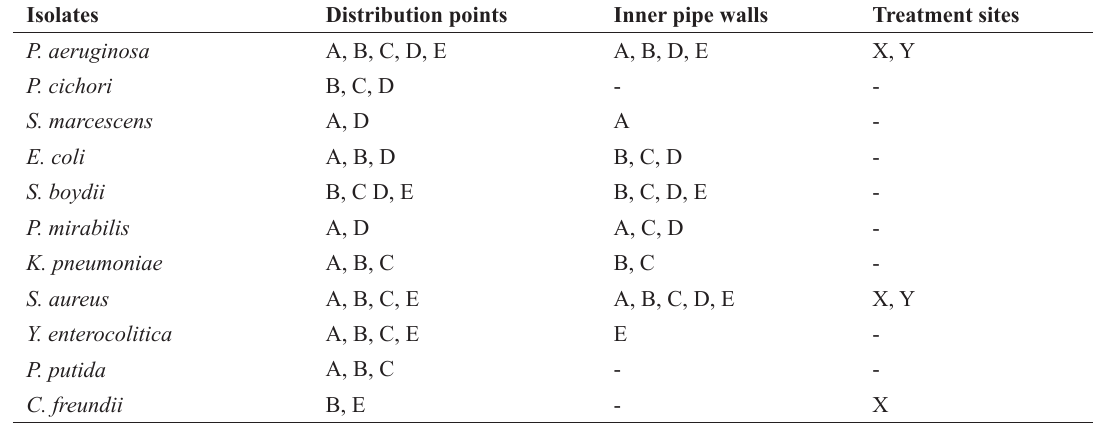
Table 3: Distribution of bacterial isolates of various sources of water distribution system Isolates Distribution points Inner pipe